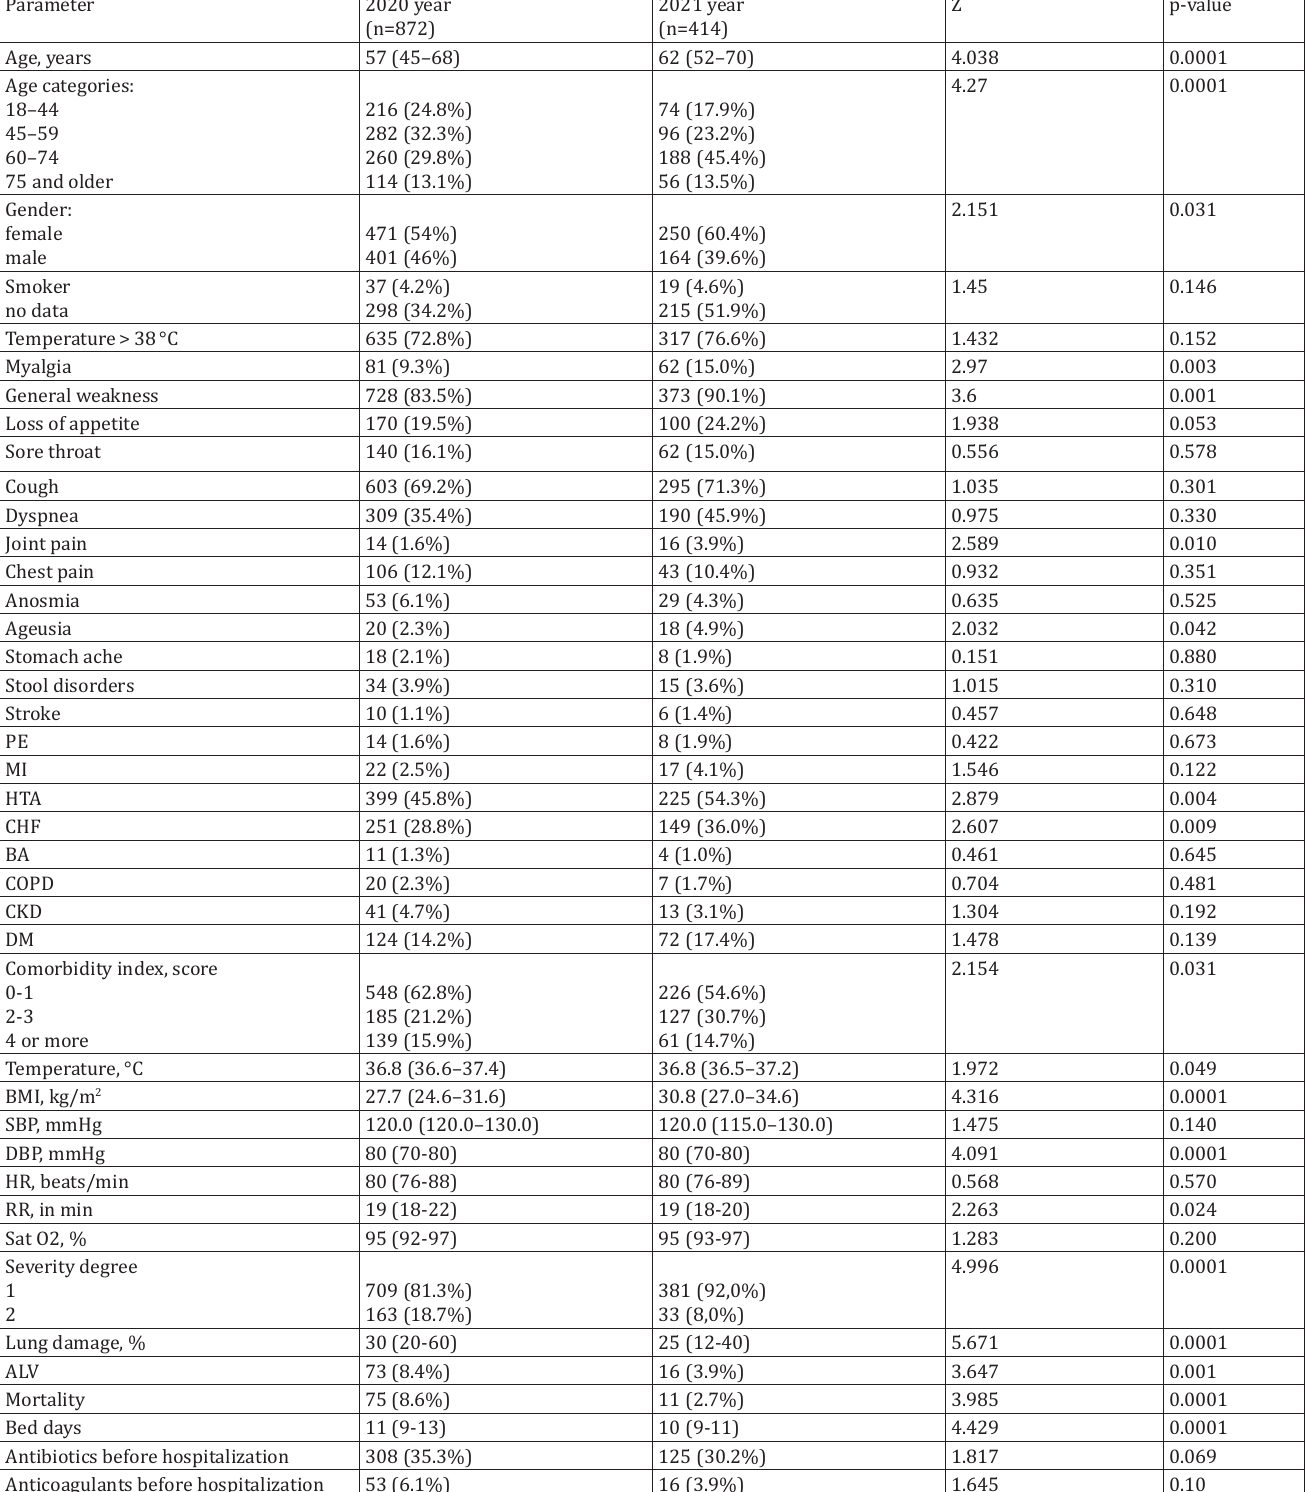
Clinical characteristics (% and median value (interquartile range)) of COVID19 inpatients in 2020 and